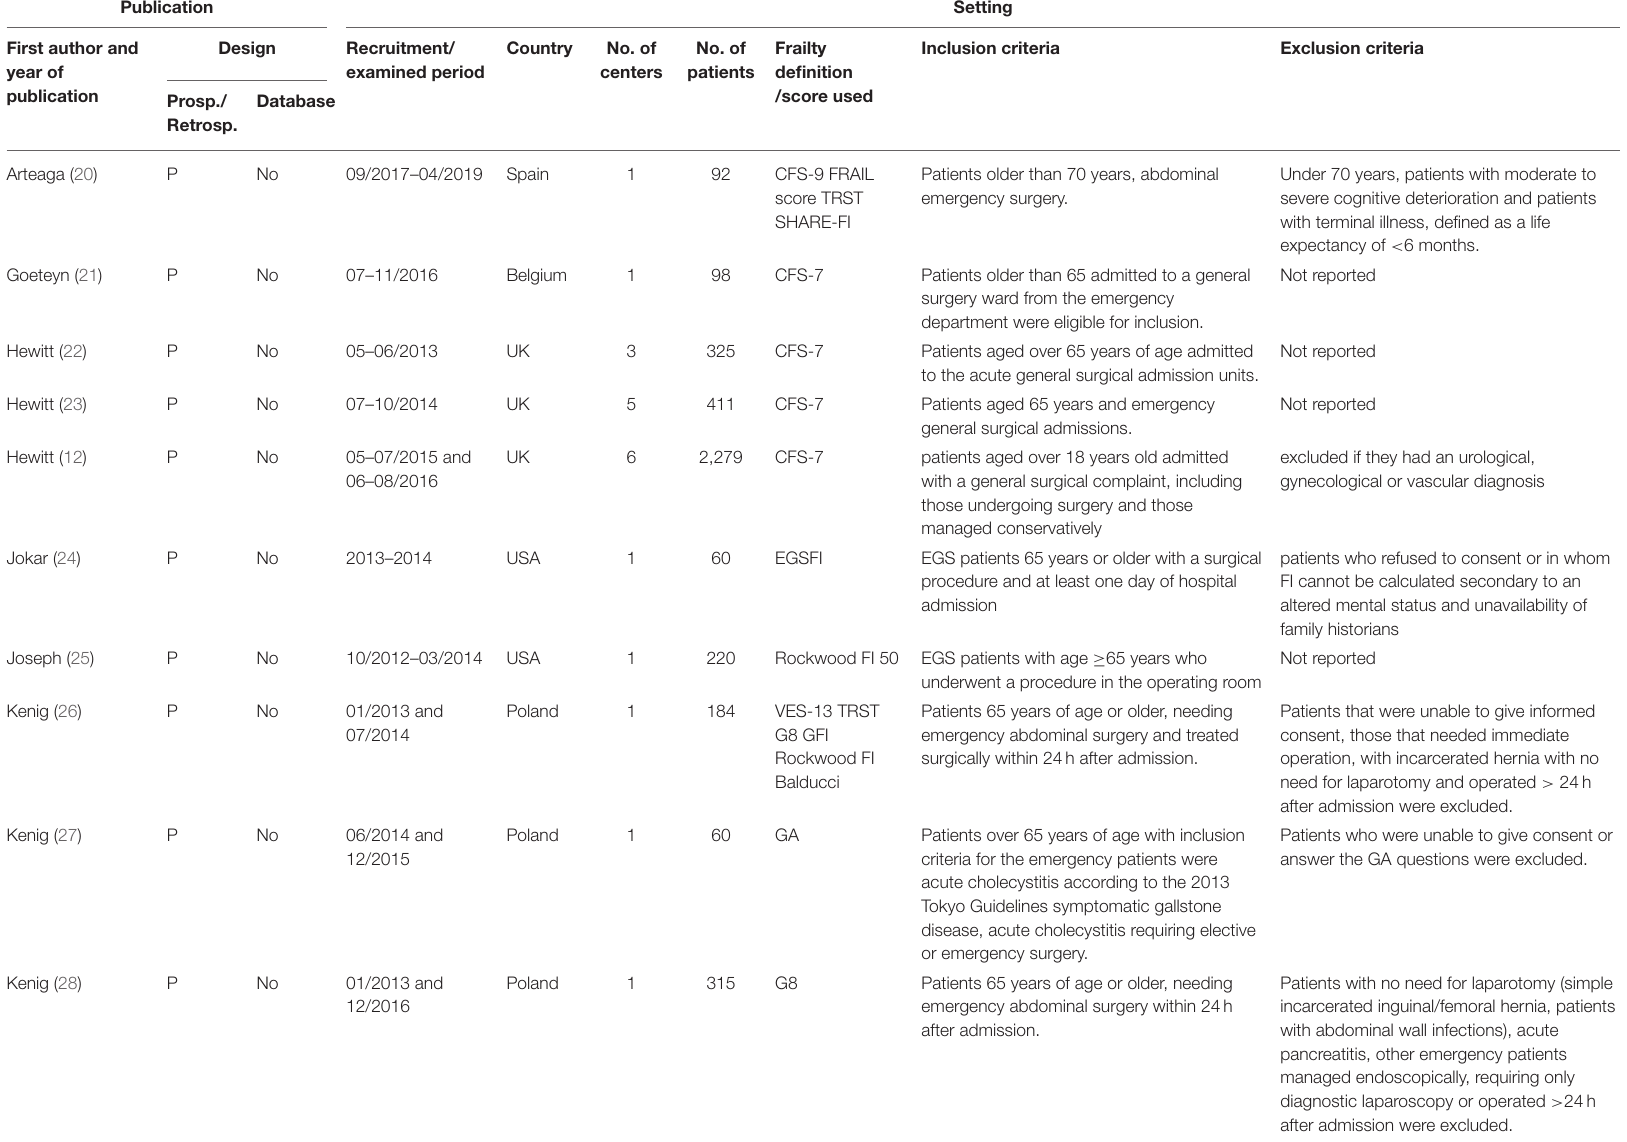
TABLE 1 | Characteristics of included